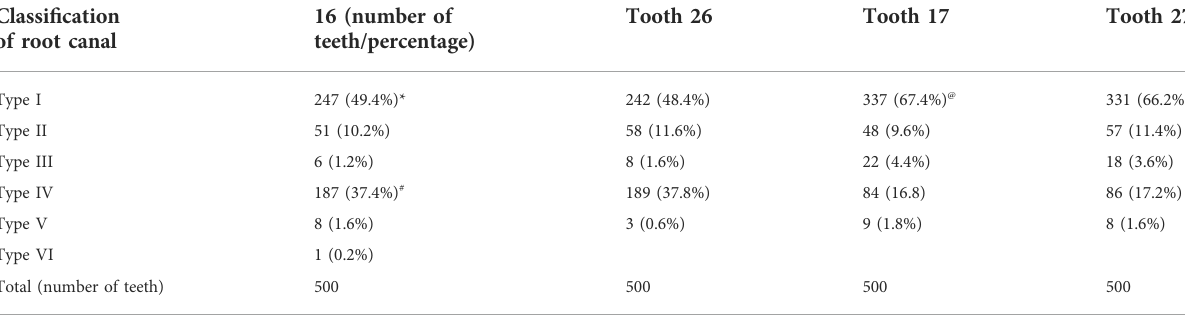
TABLE 5 The composition of MB in maxillary fi rst and second molars in FuJian